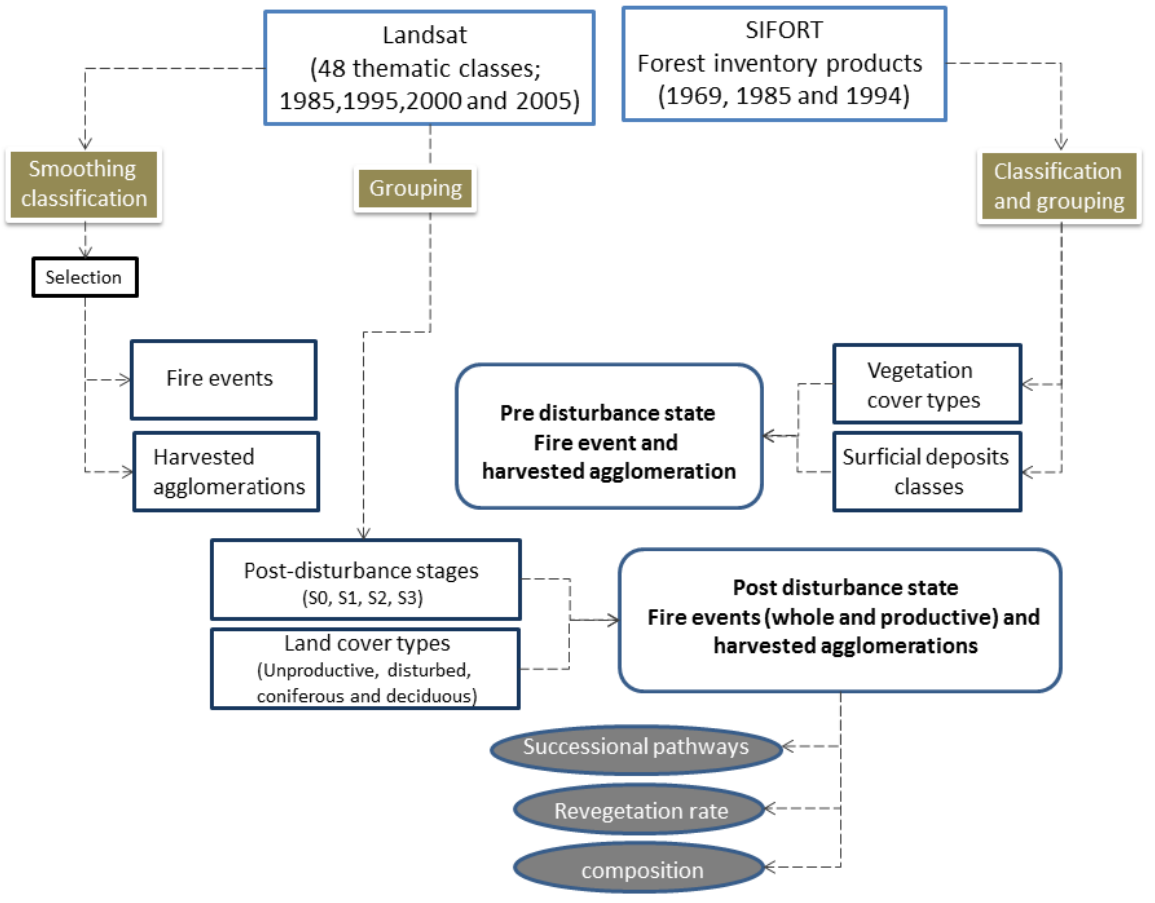
Figure 2. Summary of the methodology steps followed in this